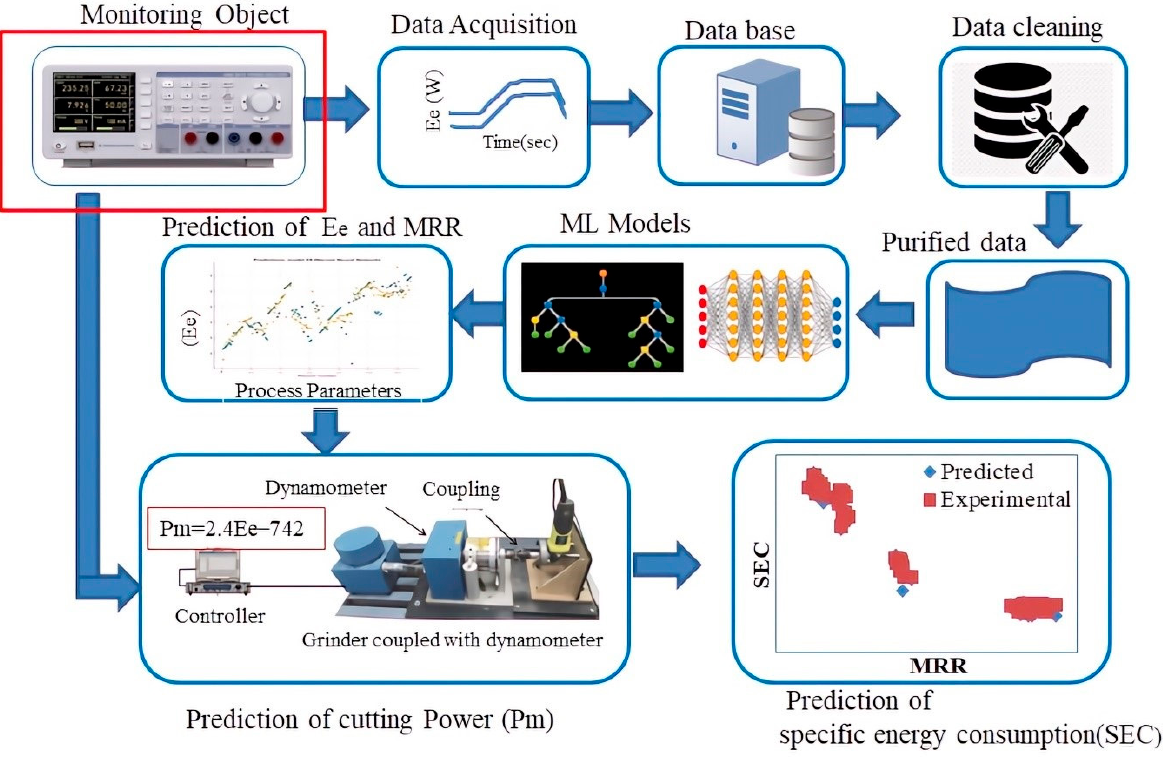
Figure 1. Overall procedure for prediction of specific energy consumption